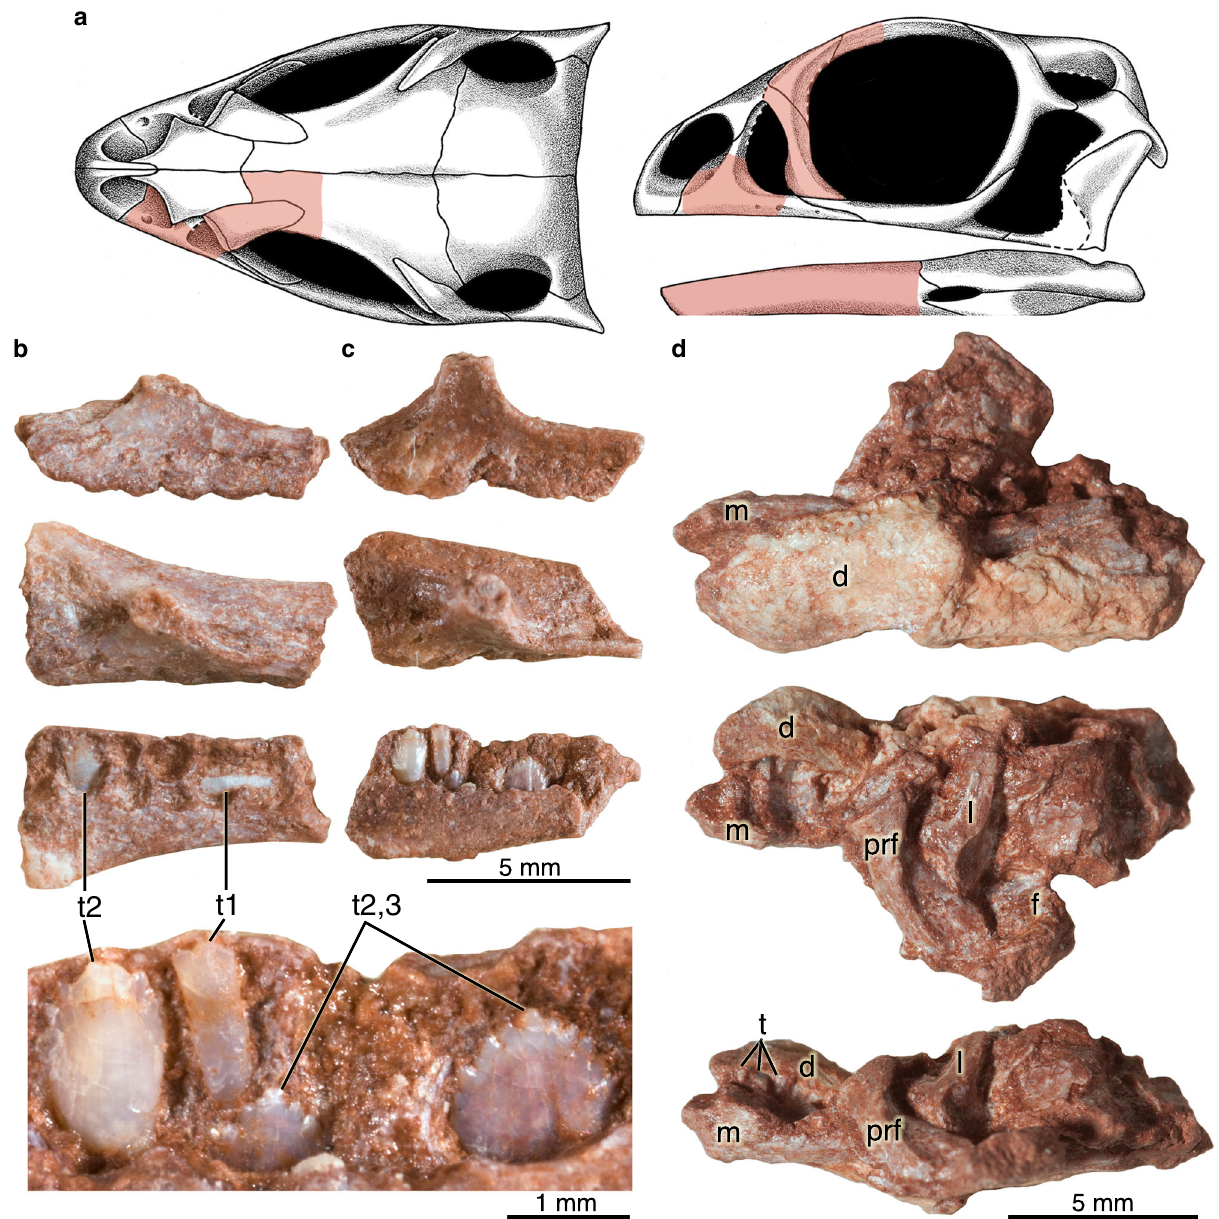
Fig. 1 Embryonic cranial materials of sauropodomorph dinosaur Lufengosaurus (Chuxiong Prefectural Museum C2019 2A233). a Reconstructed embryonic skull 18,19 in dorsal and lateral views, showing preserved portions of the skull. b Left maxilla with two preserved teeth in lateral, dorsal, and ventral views. c Left maxilla with four preserved teeth in lateral, dorsal, and ventromedial views, with enlarged view of four maxillary teeth, showing crown anatomy in two distinct generations of unerupted teeth. d Cranial fragment showing maxilla and dentary bones in partial lateral, medial, and dorsal views. Abbreviations: d, dentary; f, frontal; l, lacrimal; m, maxilla; prf, prefrontal; t, teeth; t1, older embryonic teeth; t2-3, younger replacement teeth. Note that t2-3 replacement teeth may represent differing generations, with the tooth to the immediate left of the t1 tooth is signi fi cantly older than the two other teeth that are just forming in this